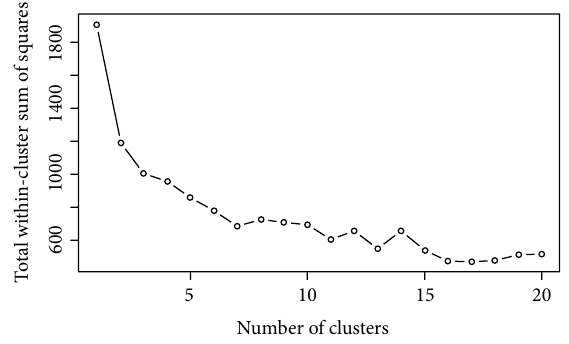
Figure 3: Proportion of variance of data explained by principal components (PCs). Figure 4: The relationship between the number of clusters and the total within-cluster sum of